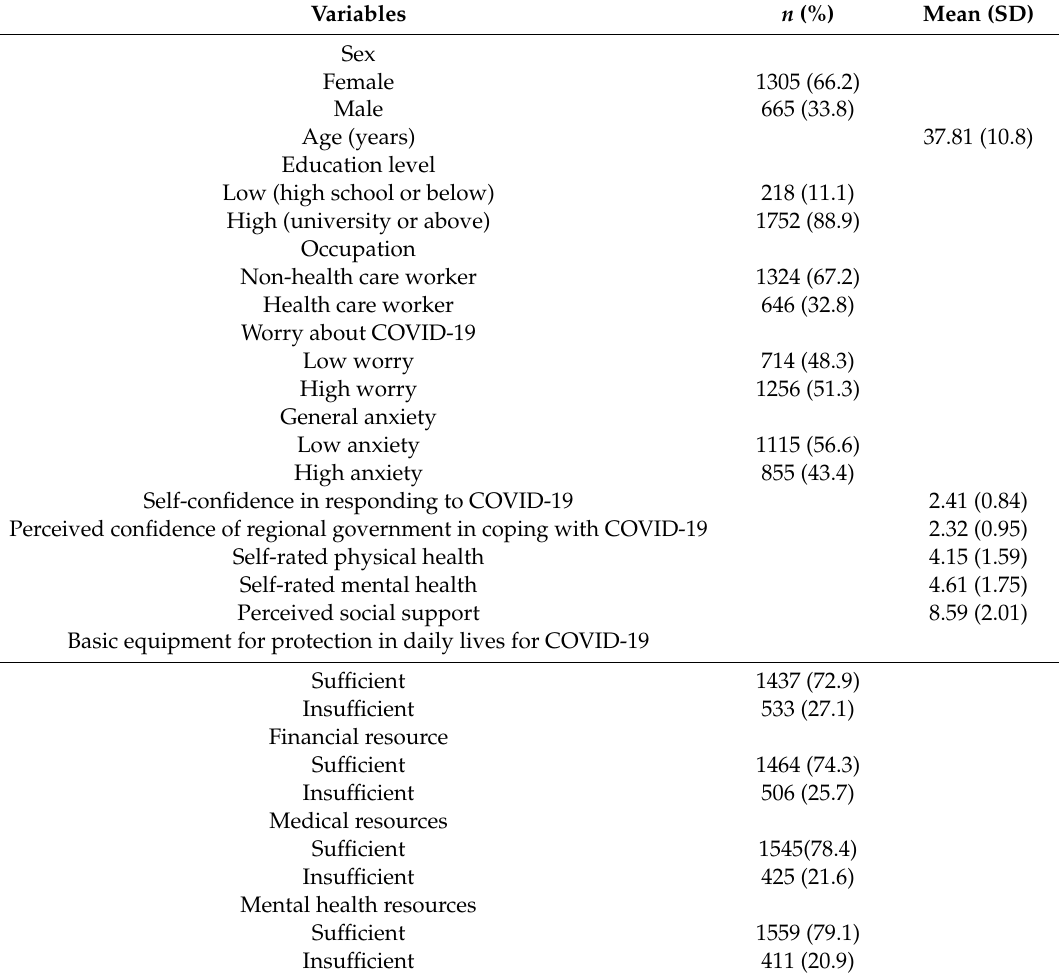
Table 1. Descriptive statistics for demographic characteristics, worry toward COVID-19, general anxiety, self-confidence in coping with COVID-19, perceived confidence in COVID-19 management by the regional government, self-rated physical and mental health, and adequacy of resources and support available for the COVID-19 pandemic ( n =